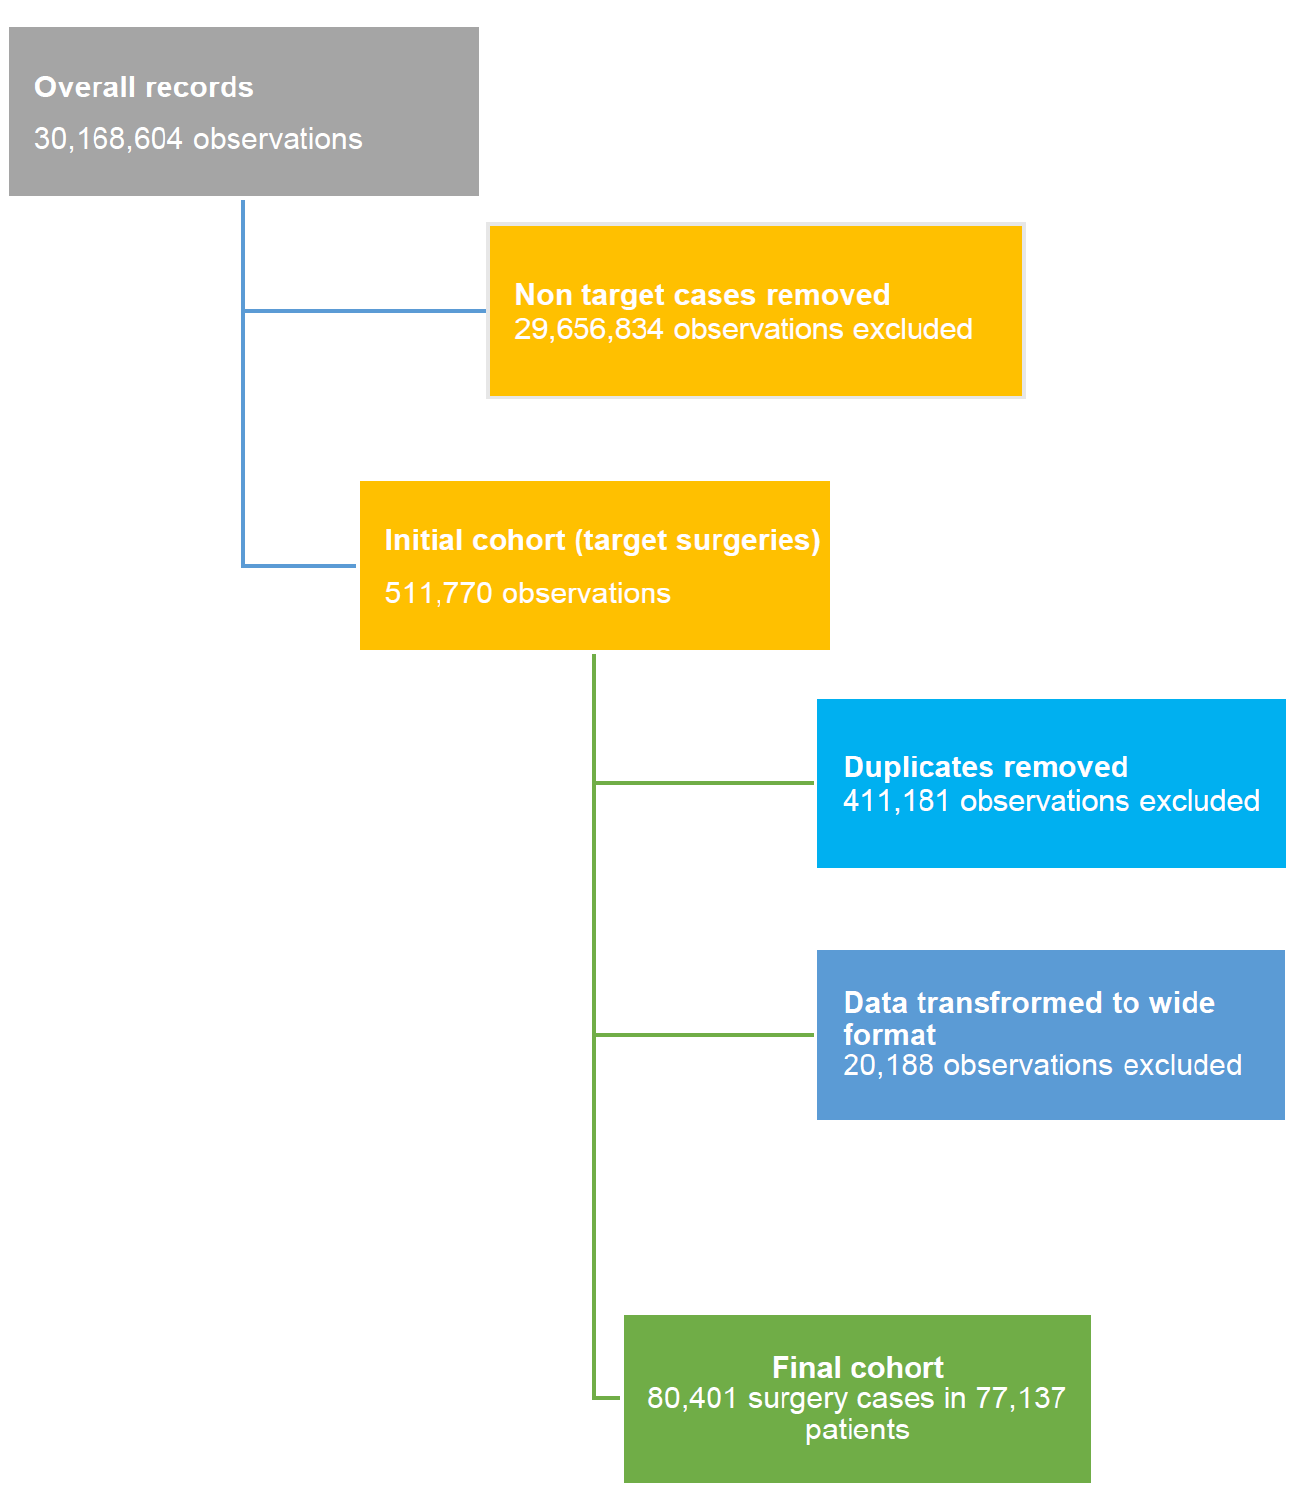
Figure 1. Patients’ selection flow chart.